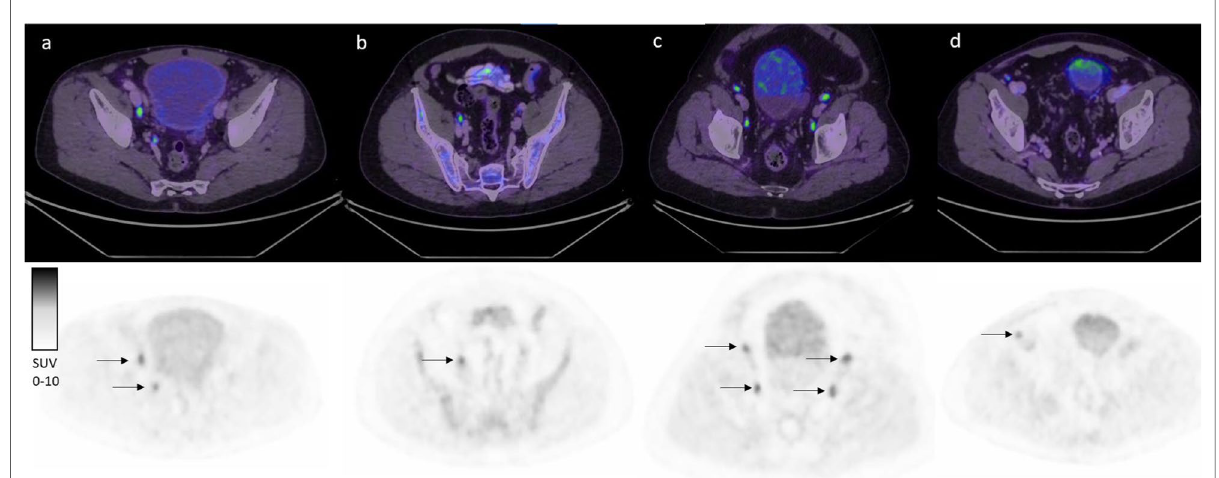
Fig. 1 Examples of true and false positives and negatives with [ 18 F]PSMA-1007 PET/CT. a True positive [ 18 F]PSMA-1007 PET/CT with low grade uptake in two lymph nodes along the right external and internal iliac vessels. PAD showed one 5 mm metastasis from the right side (presumably from the internal iliac since the lymph node along the external vessels measured 12 mm and was PSMA in its entirety) and one 1,5 mm from + the left (not detected by PET/CT). b False positive [ 18 F]PSMA-1007 PET/CT with low grade uptake in one lymph node along the right external iliac vessels. c True negative [ 18 F]PSMA-1007 PET/CT with low grade uptake in several lymph nodes along the external vessels bilaterally. d False negative [. 18 F]PSMA-1007 PET/CT with faint uptake in three lymph nodes along the external vessels bilaterally (only on shown in